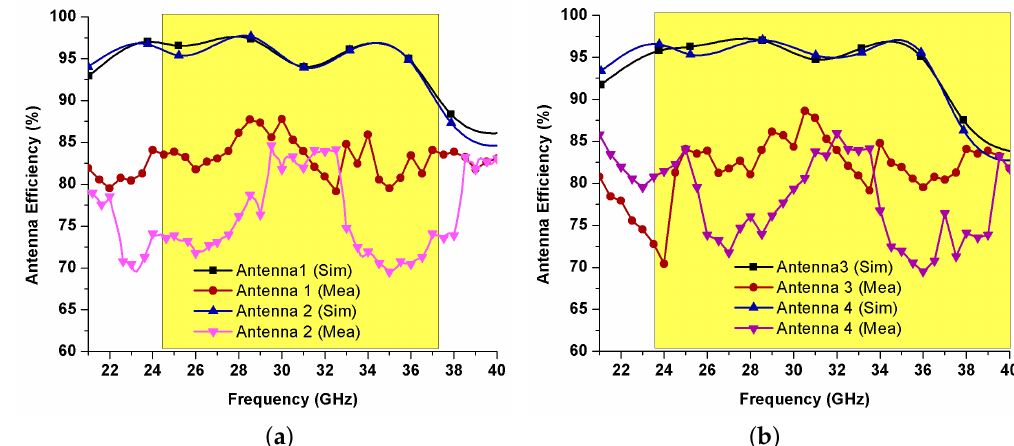
Figure 12. Efficiencies of the proposed MIMO antenna system: ( a ) antenna 1 and 2; ( b ) antenna 3 and